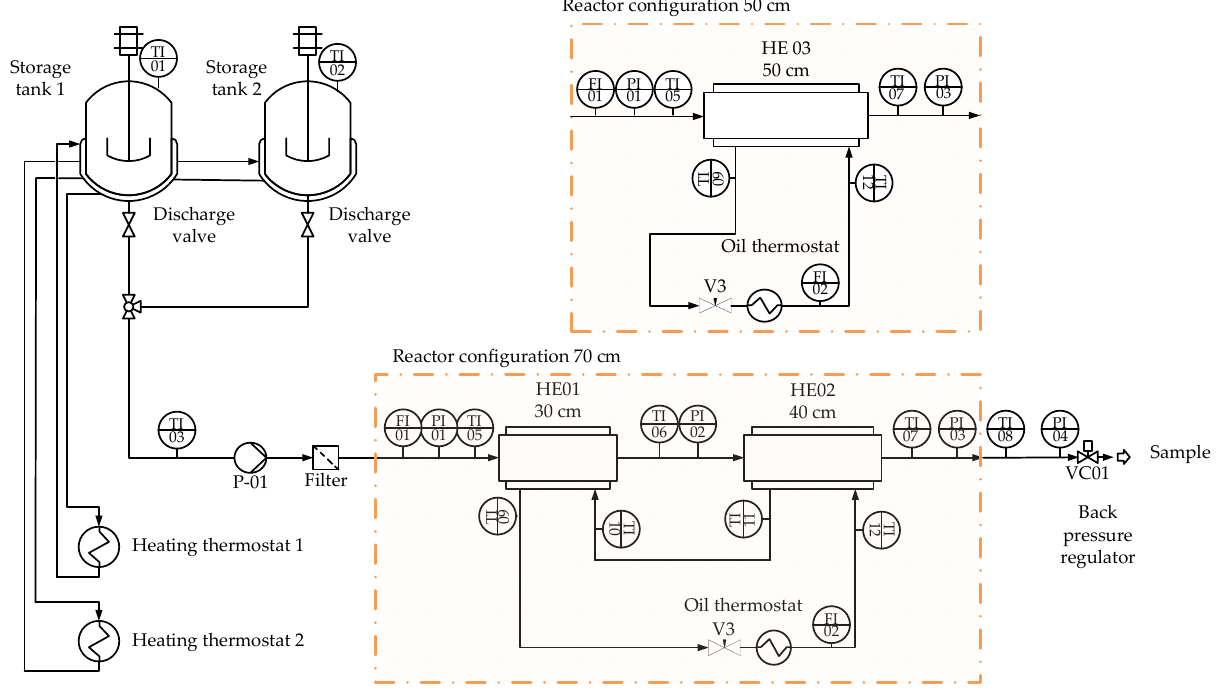
Figure 4. Experimental plant for the production of polydextrose in double-pipe reactors fitted with internal inserts.